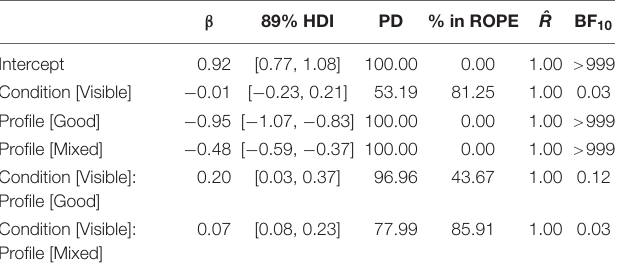
Profile (Good, Mixed, and Bad) on users’ judgment confidence ratings. The latent ordinal thresholds (i.e., nine intercepts) were estimated from a single fixed threshold (the lowest value) across users. The results are presented in Table 4